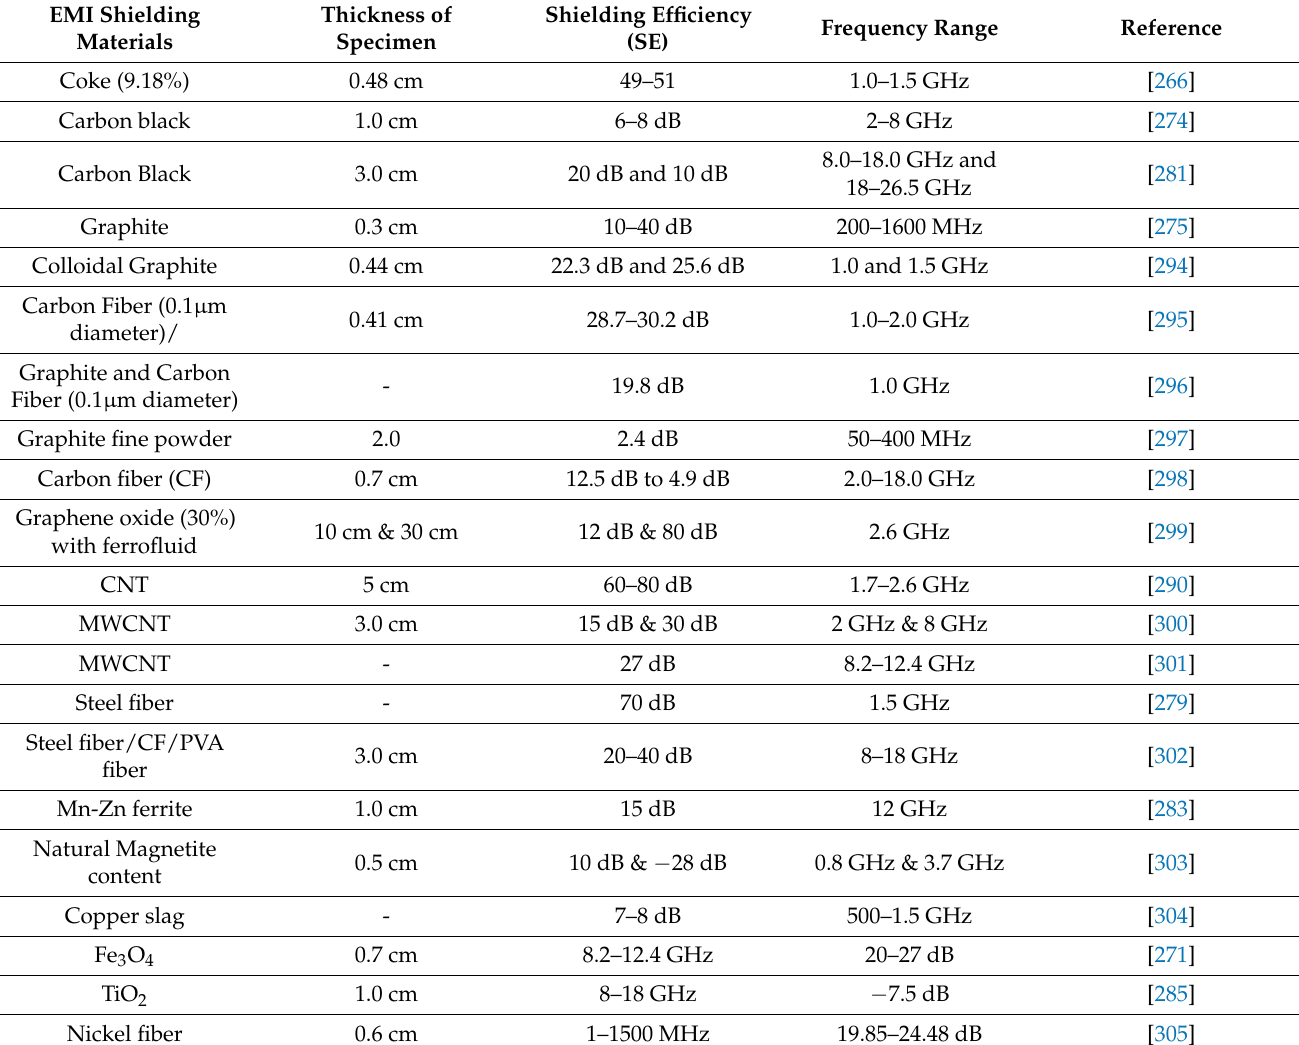
Table 9. Electromagnetic shielding effectiveness of concrete with various chemical